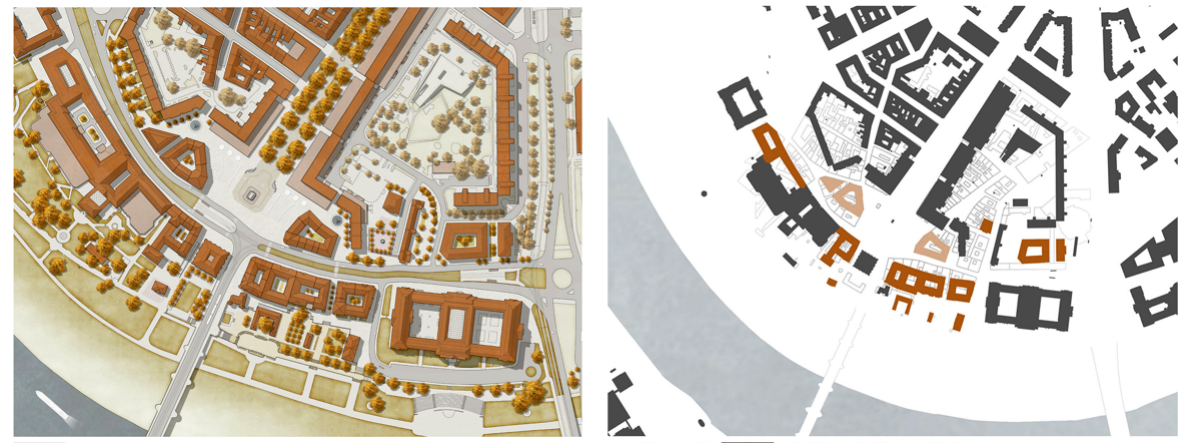
Figure 23. Königsufer and Neustädter Markt , Dresden, Bernd Albers. From left to right: masterplan; overlay on the historic fabric. Source: Albers